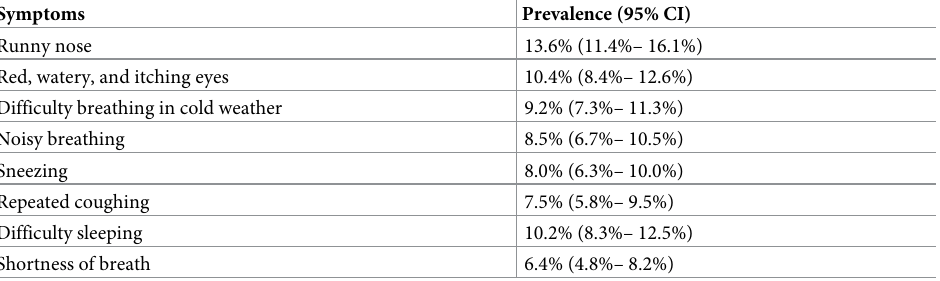
Table 2. Self-reported prevalence of respiratory allergy symptoms in Qassim, KSA, September–December 2020. Symptoms